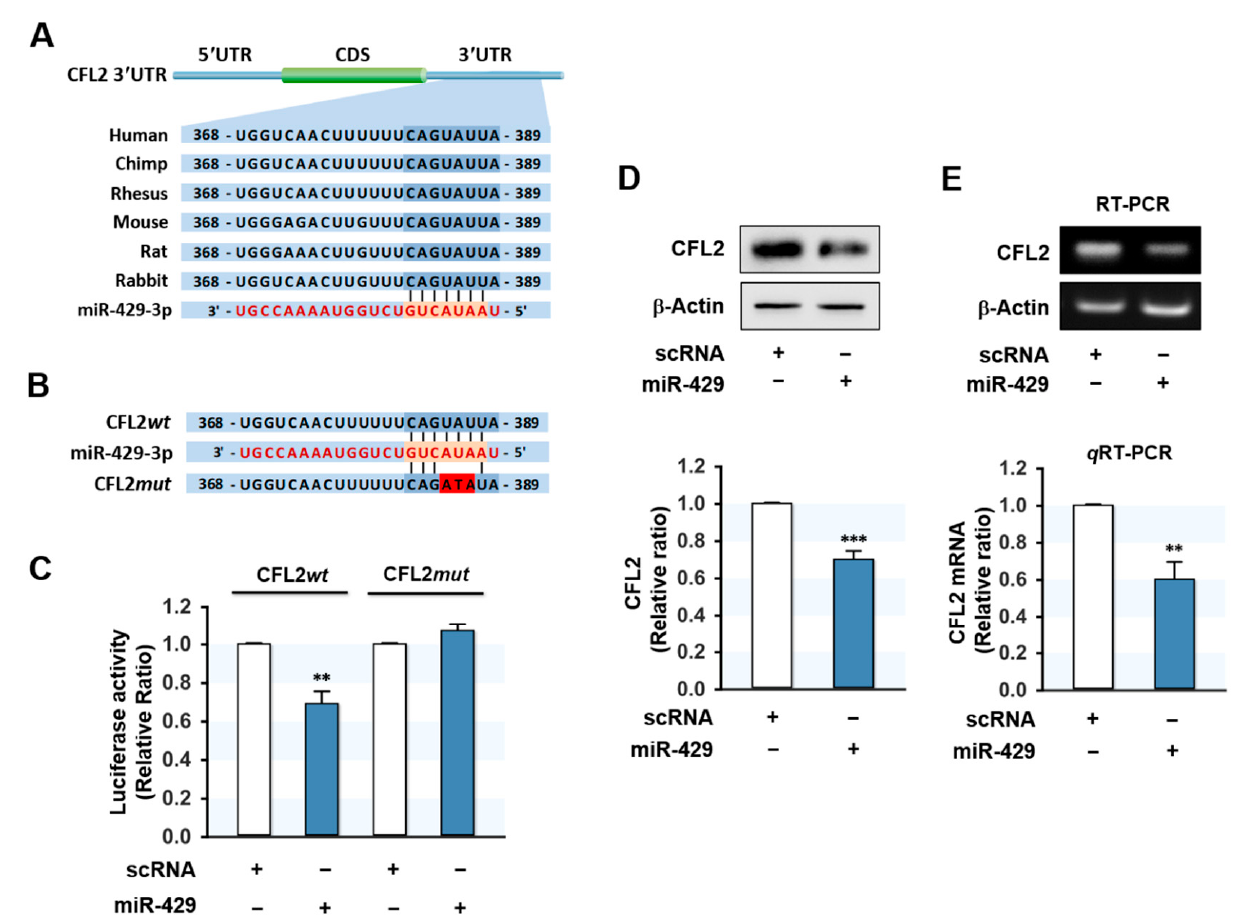
Figure 2. CFL2 is a target gene of miR-429-3p. ( A ) Diagram showing that the 3 (cid:48) UTR fragment of CFL2 contains a miR-429-3p binding site. ( B ) Sequences of the wild type (CFL2 wt ) and mutant (CFL2 mut ) CFL2 3 (cid:48) UTR for miR-429-3p binding. ( C ) pmirGLO-CFL2 wt or pmirGLO-CFL2 mut plasmids were co-transfected with scRNA or miR-429-3p into C2C12 cells. Luciferase reporter assays were performed 24 h later. ( D ) Immunoblot analysis of CFL2 at 24 h after transfection with 200 nM of scRNA or miR-429-3p mimic. ( E ) RT-PCR (upper) and q RT-PCR (lower) analysis of CFL2 expression at 24 h after transfection. The level of expression was normalized to the amount of ß-Actin. q RT-PCR and immunoblot results are shown as relative ratios vs. scRNA. All results are presented as means ± SEM ( n > 3), and levels of significance are presented as ** p < 0.01; *** p < 0.001 vs. scRNA.